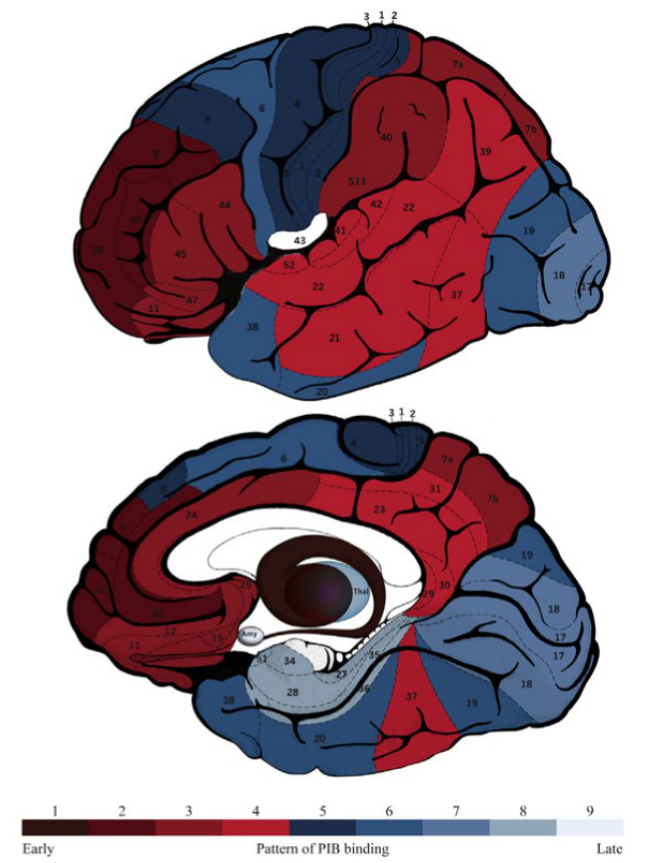
Figure 4. A schematic brain map of numbered Brodmann areas and subcortical regions of interest colored according to the PIB staging model in DS, where shade 1 denotes the area affected first (i.e., the striatum) and shade 9 the area affected latest (the amygdala). Abbreviations: thal, thalamus; amyamyg- dala; PIB, Pittsburgh compound – B. From, Annus et al., 2016 [174].